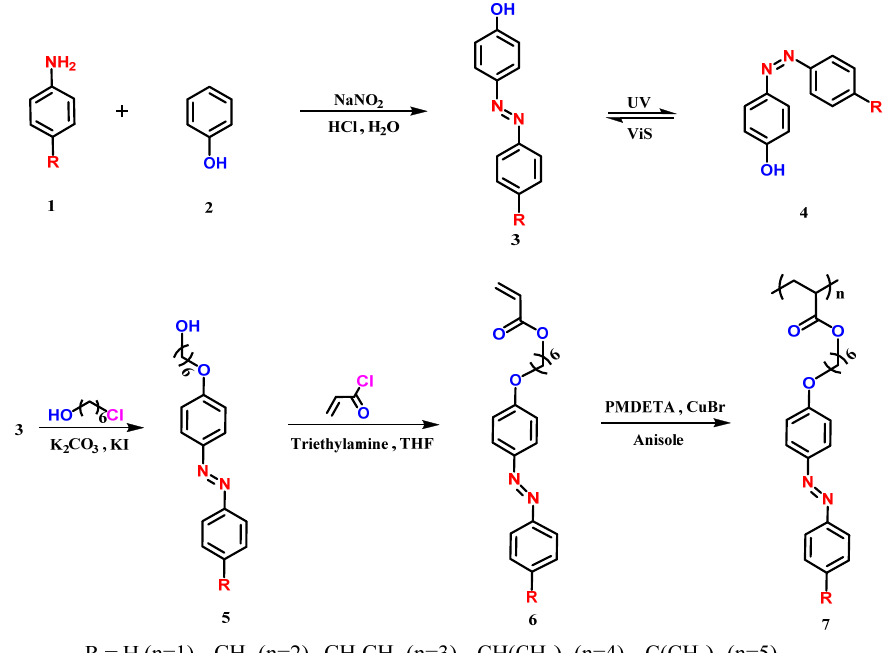
Figure 1. Schematically illustration of the synthesis of monomers M-n-Azo (6) and azopolymers P-n-Azo (7), n =